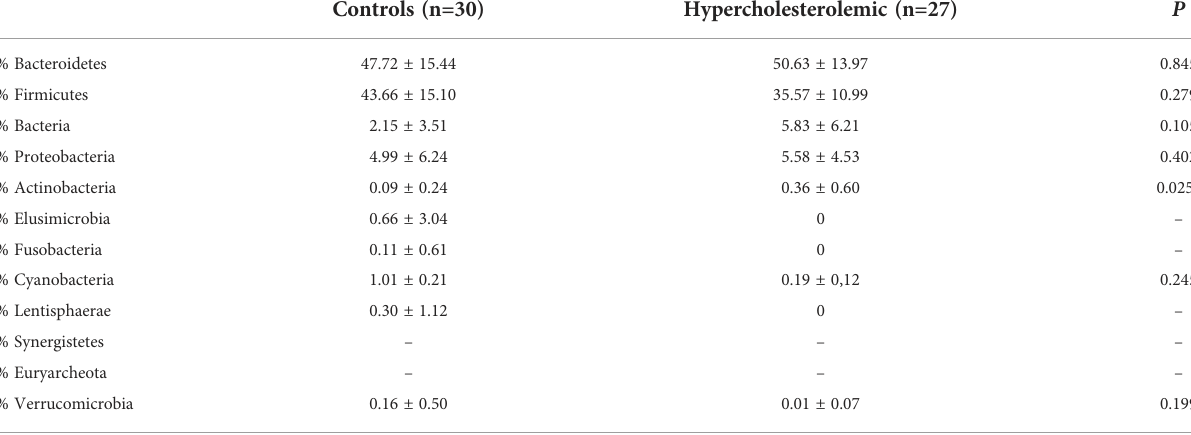
TABLE 2 Bacterial phylum detected in fecal samples of hypercholesterolemic individuals and